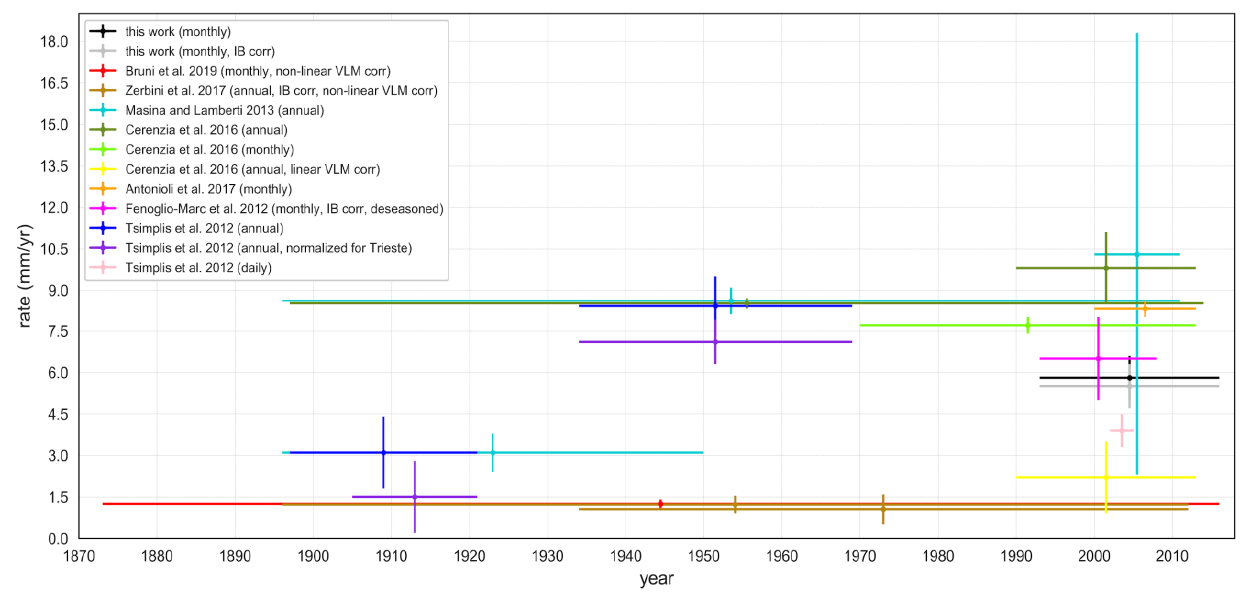
Figure 5. Rates of sea-level change obtained by some of the most representative studies on TG RA . Vertical bars represent error associated with the rate, while horizontal bars reflect the considered timespan.